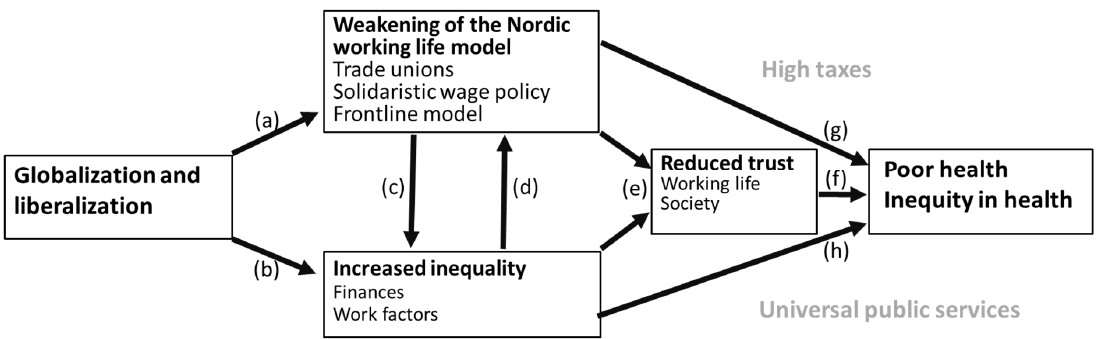
Figure 2. Relationships between globalization, the Nordic working life model, trust, and public